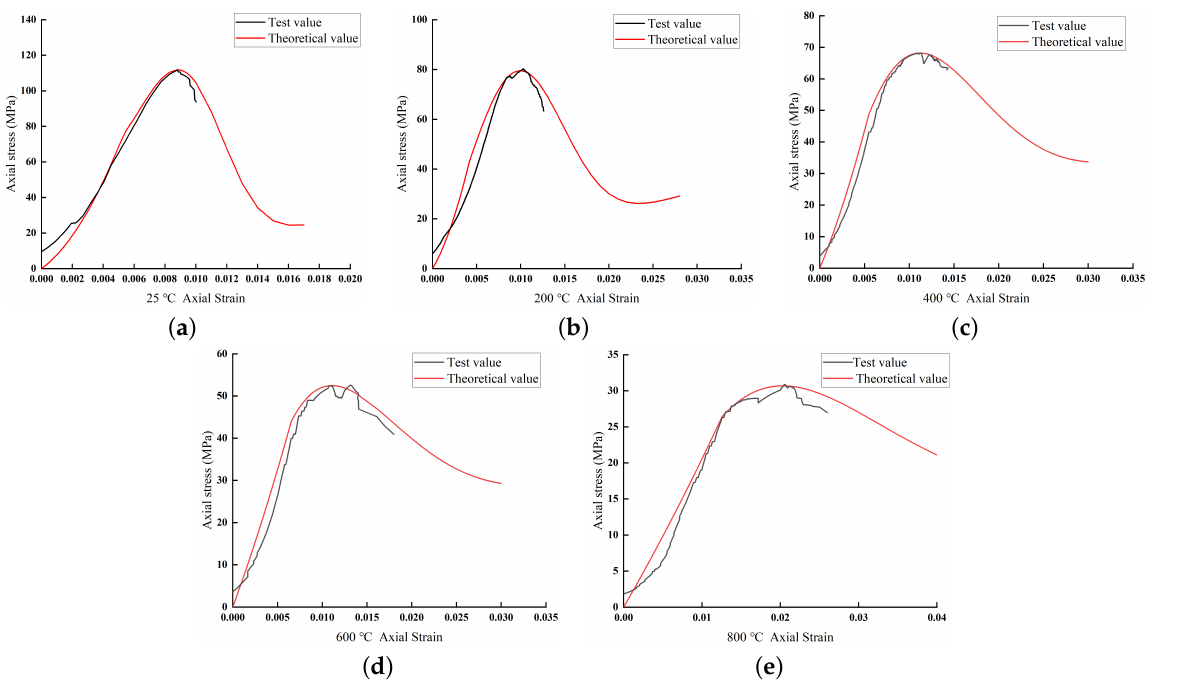
Figure 10. Comparison between the theoretical value and the experimental value. ( a ) T = 25 ◦ C; ( b ) T = 200 ◦ C; ( c ) T = 400 ◦ C; ( d ) T = 600 ◦ C; ( e ) T = 800 ◦